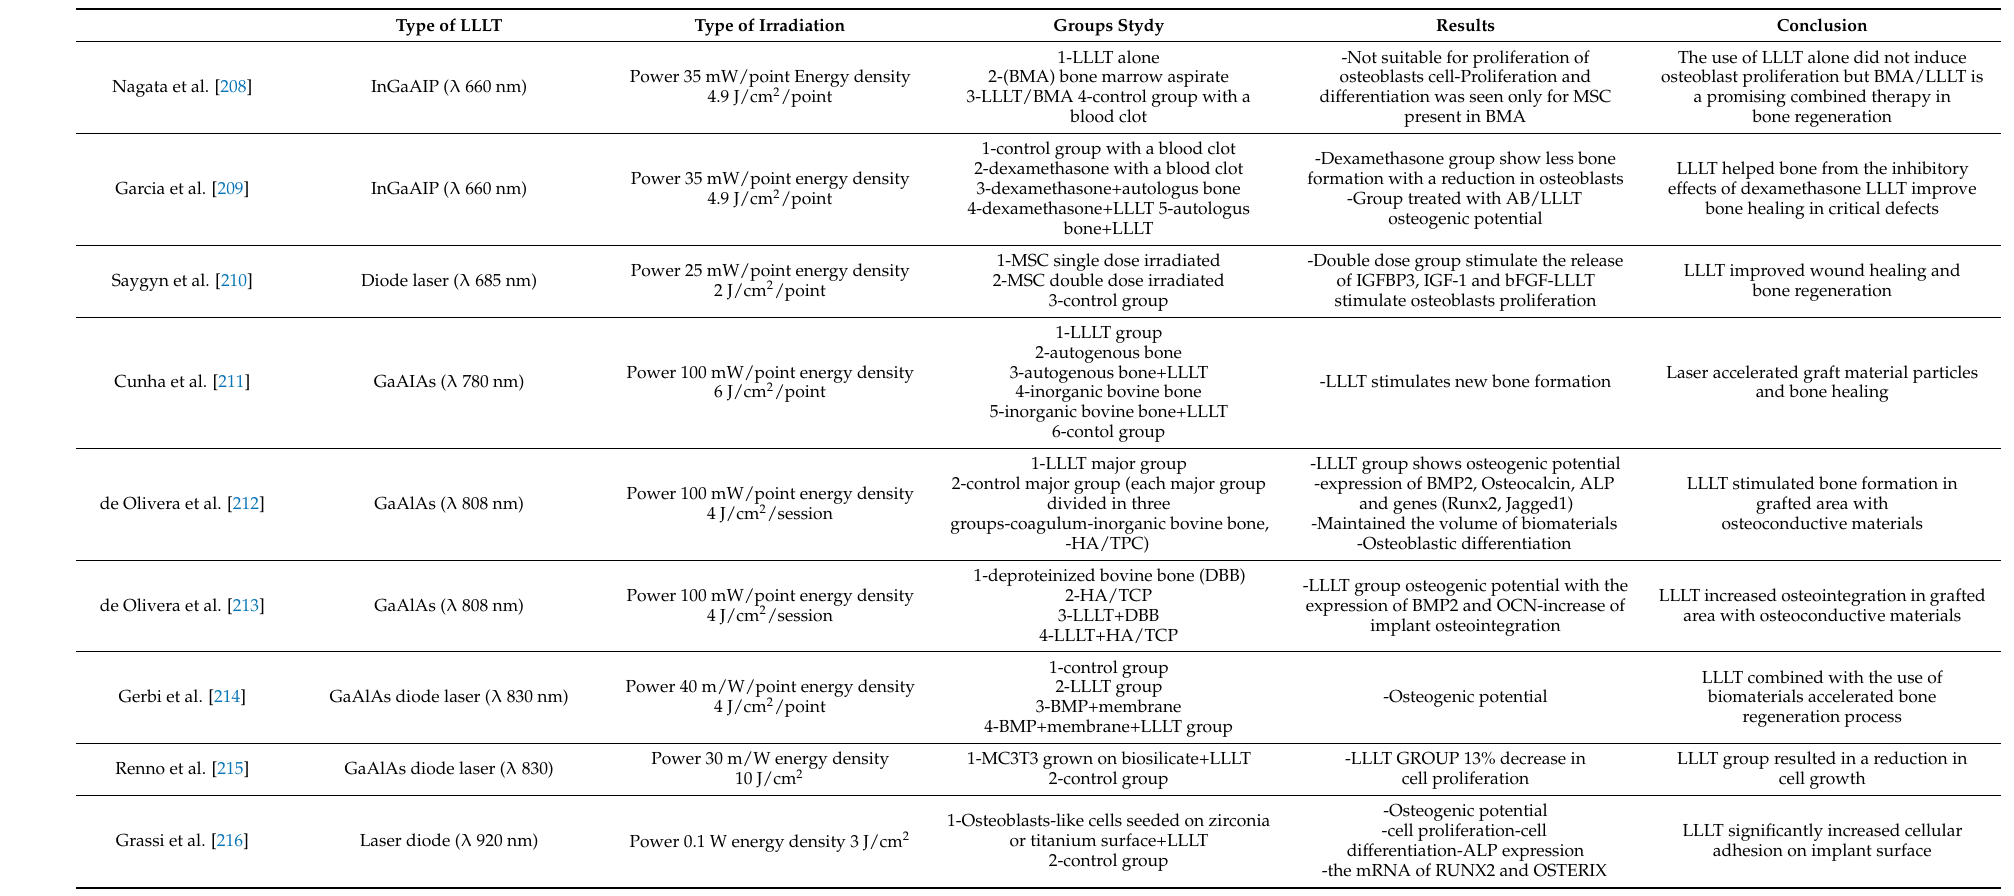
Table 2. Summary of the laser protocols for biomaterials osseointegration